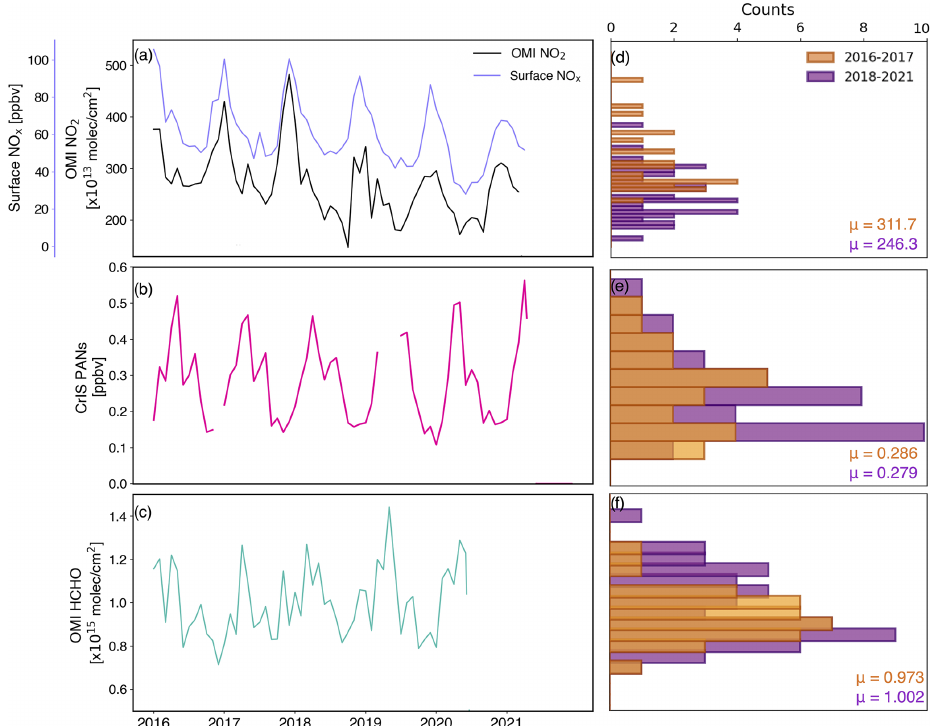
Figure 8. (a) Monthly average of OMI NO 2 (dark blue) and RAMA surface NO x observations (light blue), (b) CrIS free-tropospheric monthly average PANs, (c) OMI HCHO tropospheric columns for 2016–2021. Distribution of OMI NO 2 (d) , CrIS PANs (e) , and OMI HCHO (f) from two populations: 2016–2017 (orange) and 2018–2021 (purple). Sample means ( µ ) are provided in their respective colors and